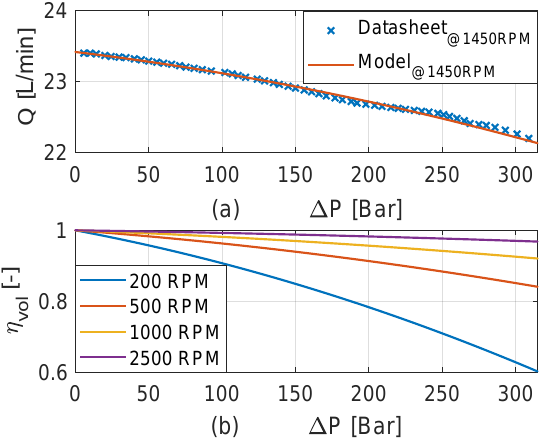
Figure 7: (a) Pump flow model compared to datasheet. (b) Pump volumetric efficiency.